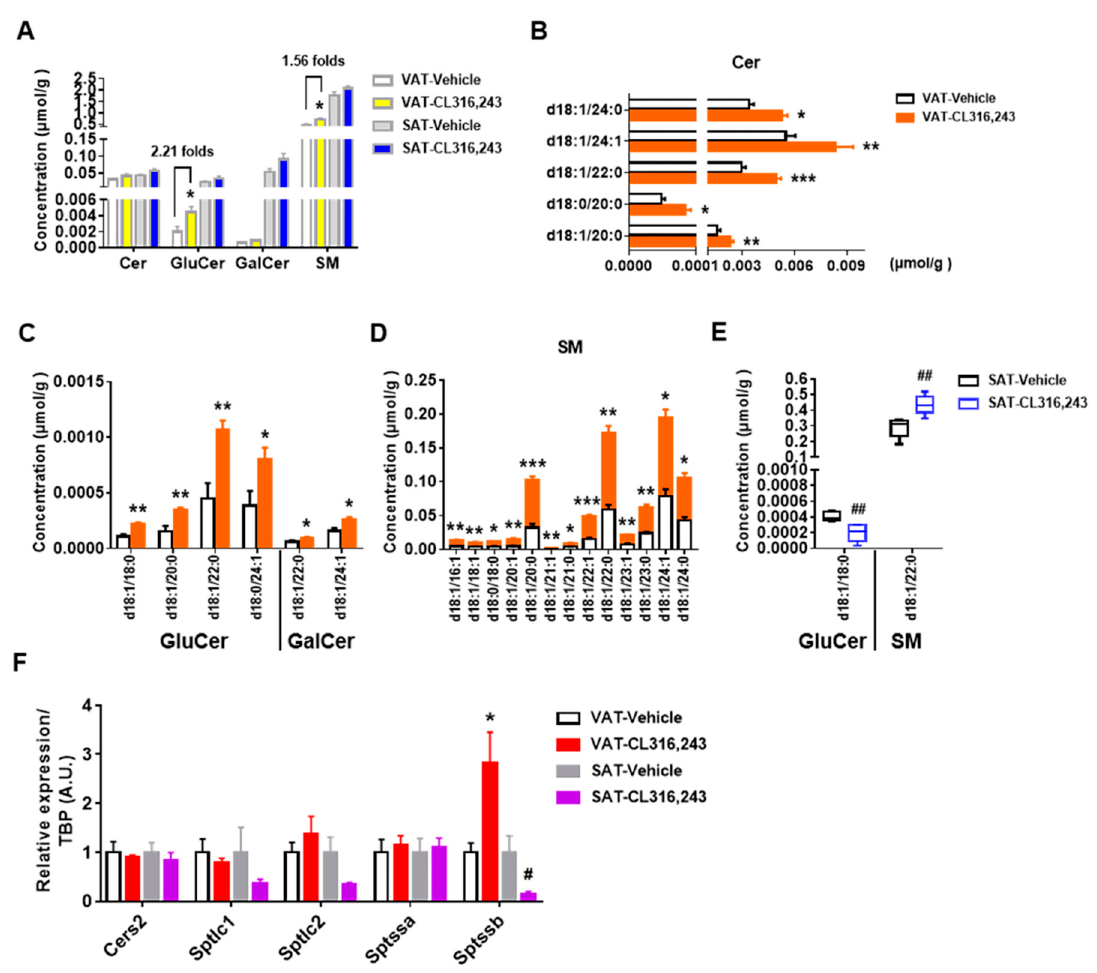
Figure 6. CL316,243 increased sphingolipids in VAT without changes in SAT. ( A ) The total concentration of sphingolipids in VAT and SAT were quantified. Concentration of ( B ) ceramide (Cer), ( C ) glucosylceramide (GluCer), galactosylceramide (GalCer), and ( D ) sphingomyelin (SM) species significantly changed in VAT after 10 days of CL316,243 injection; ( E ) The molecular species of GluCer and SM changed in VAT by CL316,243. All data are presented as mean ± SEM, n = 5. * P < 0.05; ** P < 0.01; *** P < 0.001 compared with VAT Vehicle group. ## P < 0.01 compared with SAT Vehicle group. ( F ) qPCR analysis of ceramide synthase 2 (Cers2), serine palmitoyltransferase long chain base subunit 1 (Sptlc1), serine palmitoyltransferase long chain base subunit 2 (Sptlc2), serine palmitoyltransferase small subunit A (Sptssa) and serine palmitoyltransferase small subunit B (Sptssb) gene expression in VAT and SAT of mice injected with CL316,243. qPCR data are normalized to TBP and presented as mean ± SEM, n = 5. * P < 0.05 compared with VAT Vehicle group. # P < 0.05 compared with SAT Vehicle group.